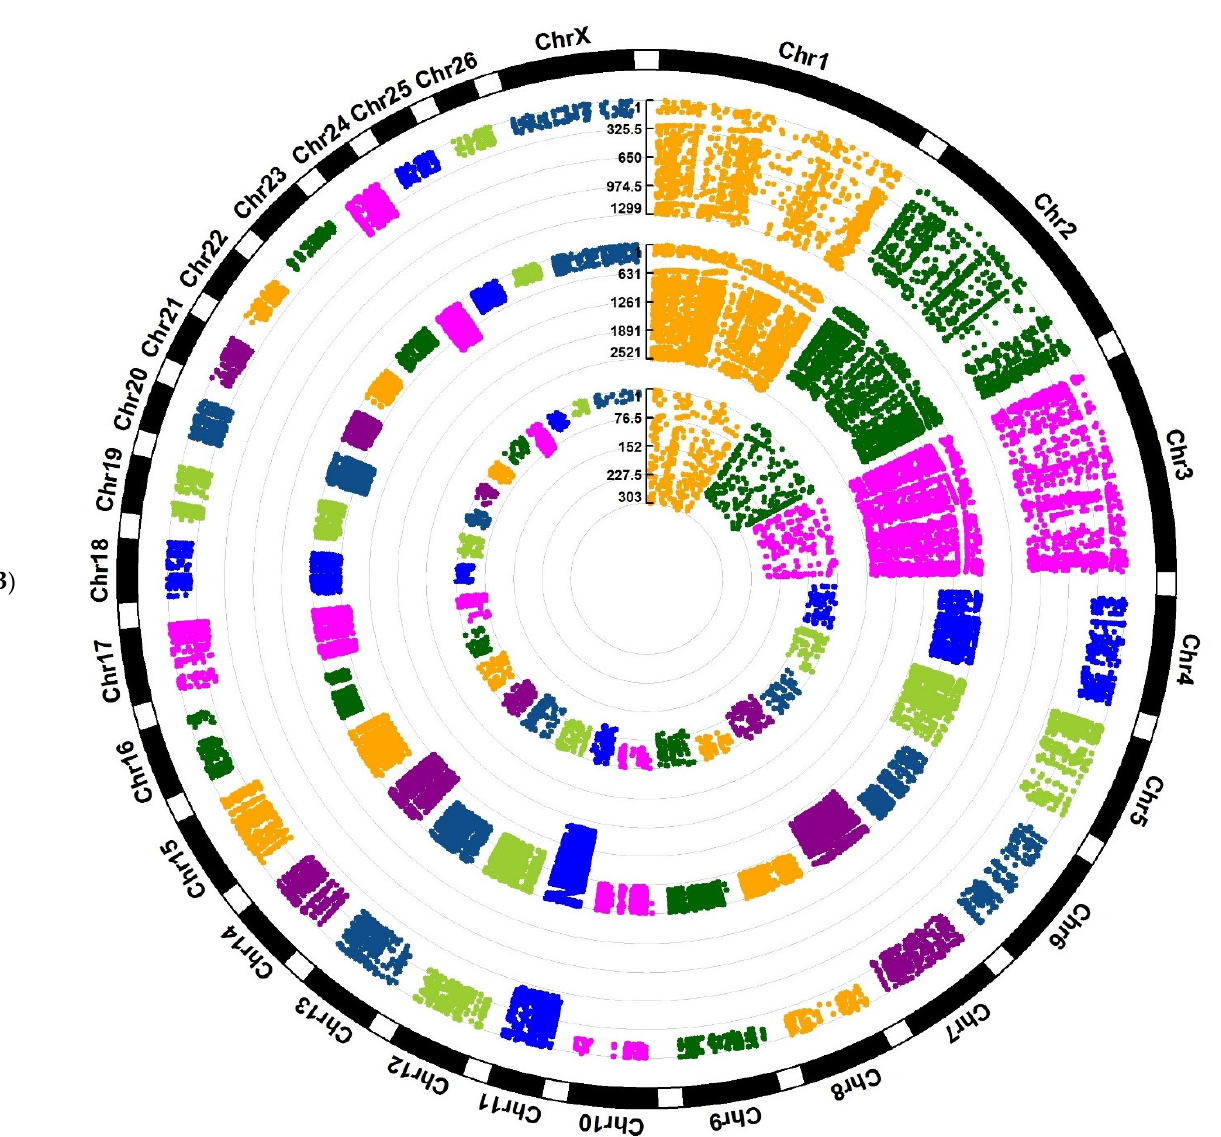
Figure 2. Circos plot of distribution and densities of sheep breed and stage-specific SNPs in ( A ) Assaf sheep breed and ( B ) Churra sheep breed. The external layer displays the chromosomes. The BP, P, and AP-specific SNPs are situated in the first, second, and third inner layers, respectively. Vertical lines in each layer represent the number of SNPs in that position.